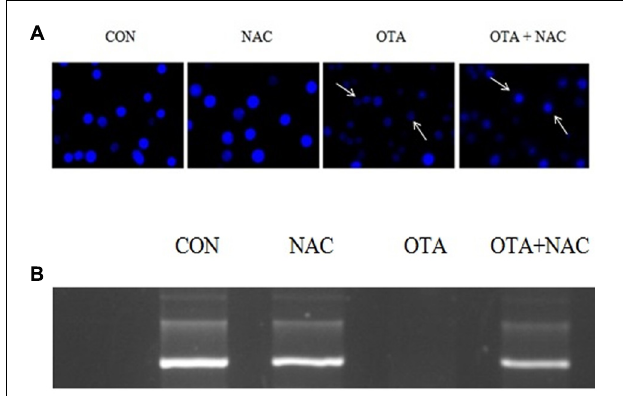
FIGURE 8 | Gene-expression profiles for neuronal biomarkers (AChE, BDNF, NOS2 and TH) were analyzed in Neuro-2a cells treated without or with various concentrations of OTA (100–500 nM) for 24 h using quantitative real time PCR. The fold change was calculated based on normalization with GAPDH gene expression. The data represented as mean ± SEM of three independent experiments. ∗ p < 0.05 versus respective control group.